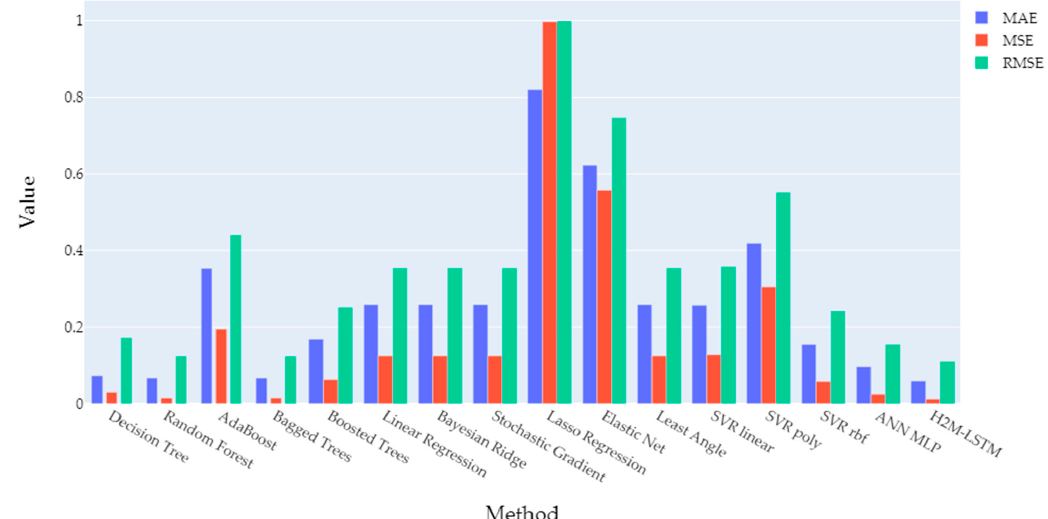
Figure 7. Barplot comparison of the performance metrics for the solar panels.